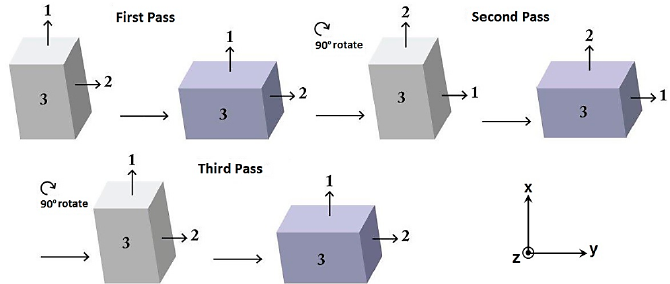
Figure 1. Schematic view of the multidirectional forging (MDF) process applied in current